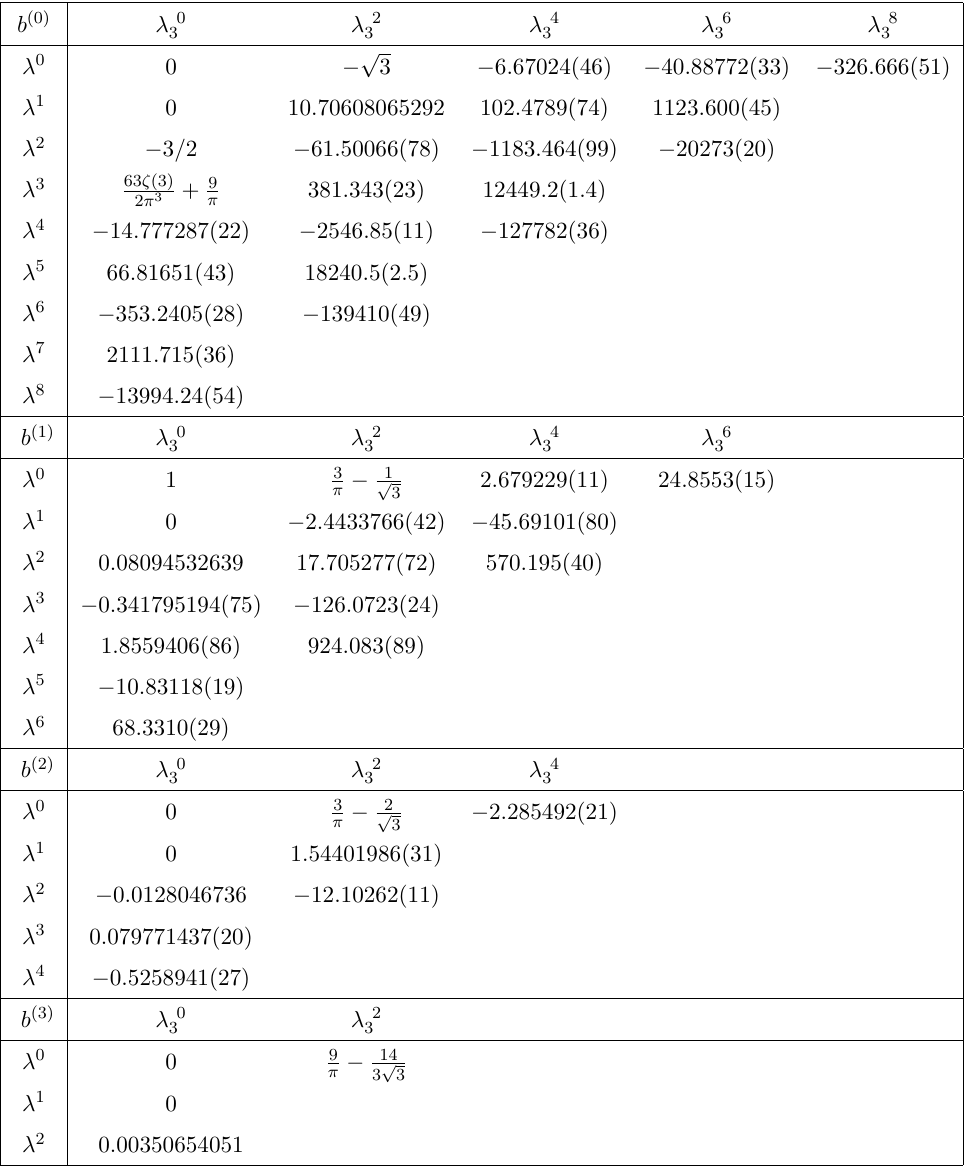
Table 8 . The coe(cid:14)cients b ( n )